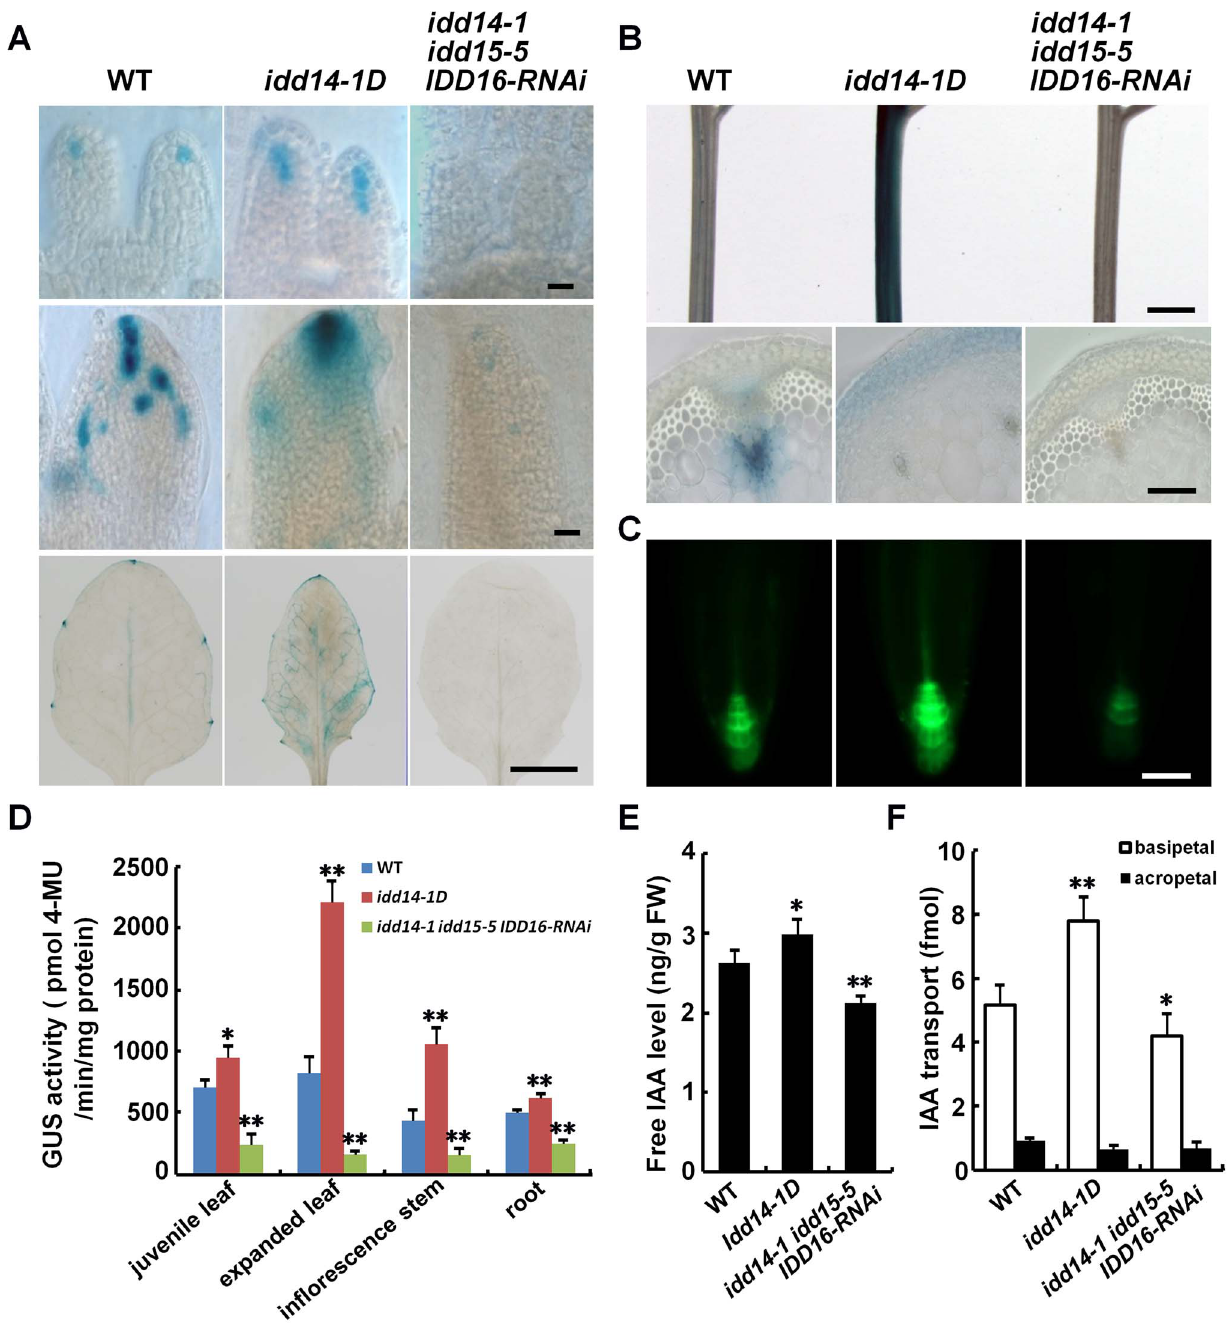
Figure 6. Altered auxin accumulation and transport in gain- and loss-of-function idd mutants. (A) Auxin accumulation assayed with the DR5:GUS reporter in WT, idd14-1D , and idd triple mutant leaves. The leaves at 3, 5, and 15 days after initiation (from top to bottom panels) were subjected to GUS staining. The scale bars represent 50 m m in the top and middle panels and 5 mm in the bottom panel. (B) Expression of the DR5:GUS reporter in inflorescence stems of WT, idd14-1D , and idd triple mutant plants. The scale bars represent 2 mm in the top panel and 100 m m in the bottom panel. (C) GFP fluorescence signals in the primary roots of WT, idd14-1D , and idd triple mutant carrying a DR5:GFP reporter. The scale bar represents 50 m m. (D) Quantification of the GUS activity in the organs of the WT, idd14-1D , and idd triple mutant carrying a DR5:GUS reporter. Data are from three biological replicates and shown as mean values 6 one SD (Student’s t -test, *P , 0.05 and **P , 0.01). (E) Endogenous free IAA levels in WT, idd14-1D , and idd triple mutant plants. Aerial organs of 15-day-old plants were used for measurement of free IAA levels. Data are from four biological replicates and are shown as mean values 6 one SD (Student’s t -test, *P , 0.05 and **P , 0.01). (F) Polar auxin transport capability of WT, idd14-1D , and idd triple mutant stems. The inflorescence stem segments of 5-week-old plants were used to determine the basipetal IAA transport efficiency and the background acropetal movement. Data are from four biological replicates and shown as mean values 6 one SD (Student’s t -test, *P , 0.05 and **P , 0.01).